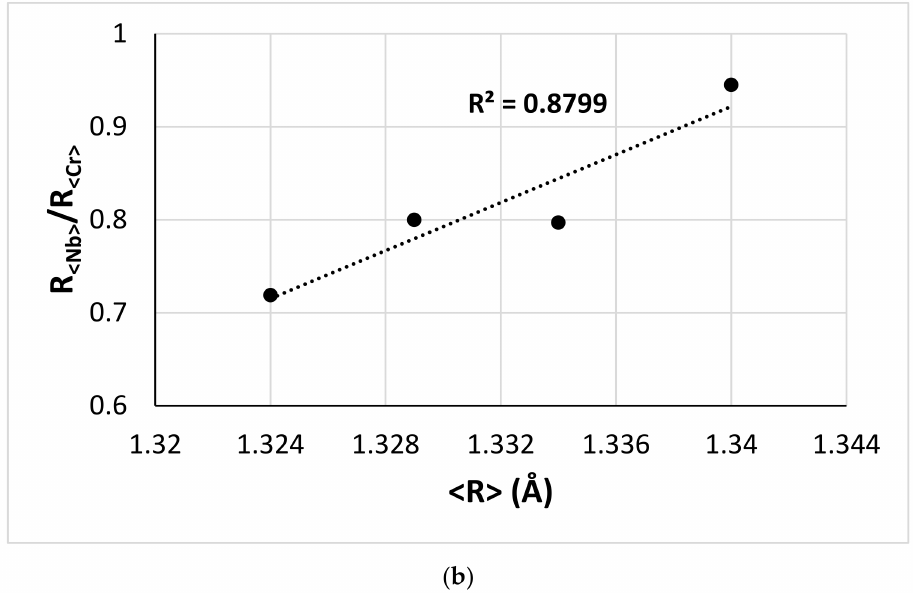
Figure 17. Data for the C14-NbCr 2 Laves phase in the alloys of this work: ( a ) VEC versus Cr content and ( b ) R <Nb> /R <Cr> versus <R> = R <Nb> + R <Cr> , where R <Nb> = ∑ in C i (r <Nb> ) i , where C i and (r <Nb> ) i are, respectively, the concentration (at.%) and atomic radius of Nb and element i substituting Nb in the Laves phase; and R <Cr> = ∑ in C i (r <Cr> ) i , where C i and (r <Cr> ) i are, respectively, the concentration (at.%) and atomic radius of Cr and element i substituting Cr in the Laves